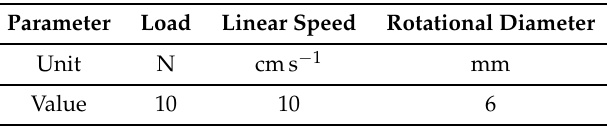
Table 3. Parameters of tribological